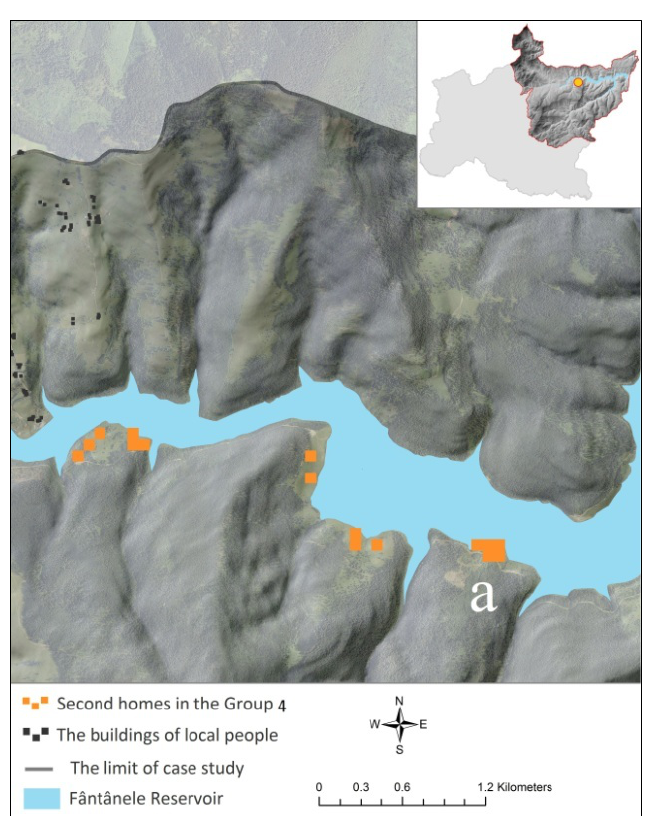
Figure 6: The spatial distribution of the group 4 in the case of shoreline settlements with vacation homes (Beliș Commune, Cluj